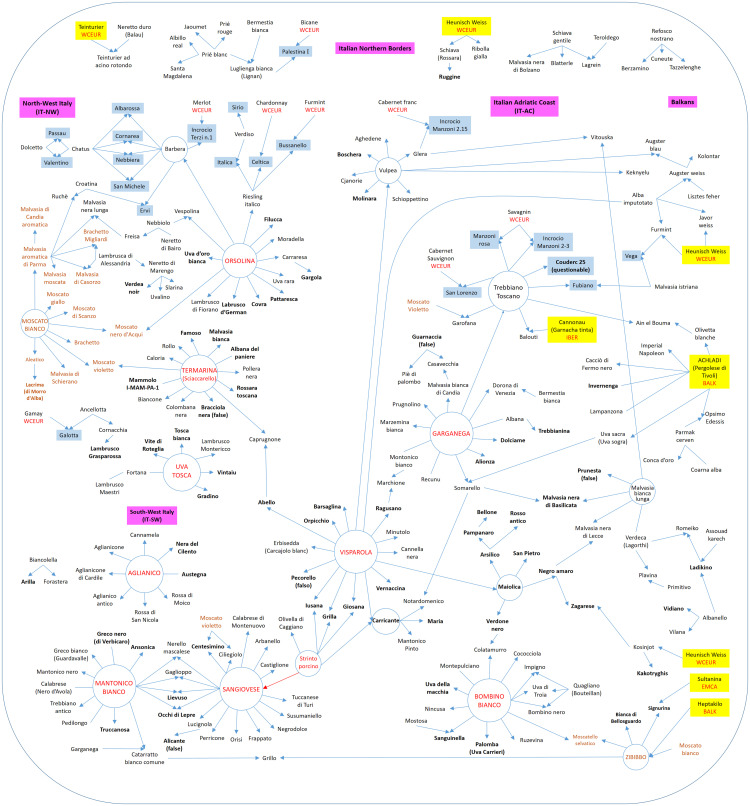
Network of main POs among Italian varieties organized according to their geographic areas. The arrows indicate PO’s direction. Bold names indicate POs reported for the first time in this study. Anthropogenic crosses are highlighted in light-blue. Parents of foreign origin contributing into spontaneous crosses are highlighted in yellow with their alleged geographic groups. Parents from the cluster of Muscat varieties are highlighted in brown. Red connectors refer to still doubtful PO direction. Connectors without arrow refer to PO without direction.